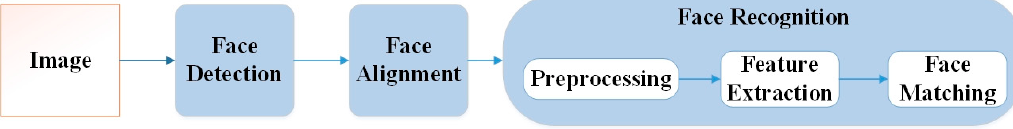
Figure 1. Face recognition system.